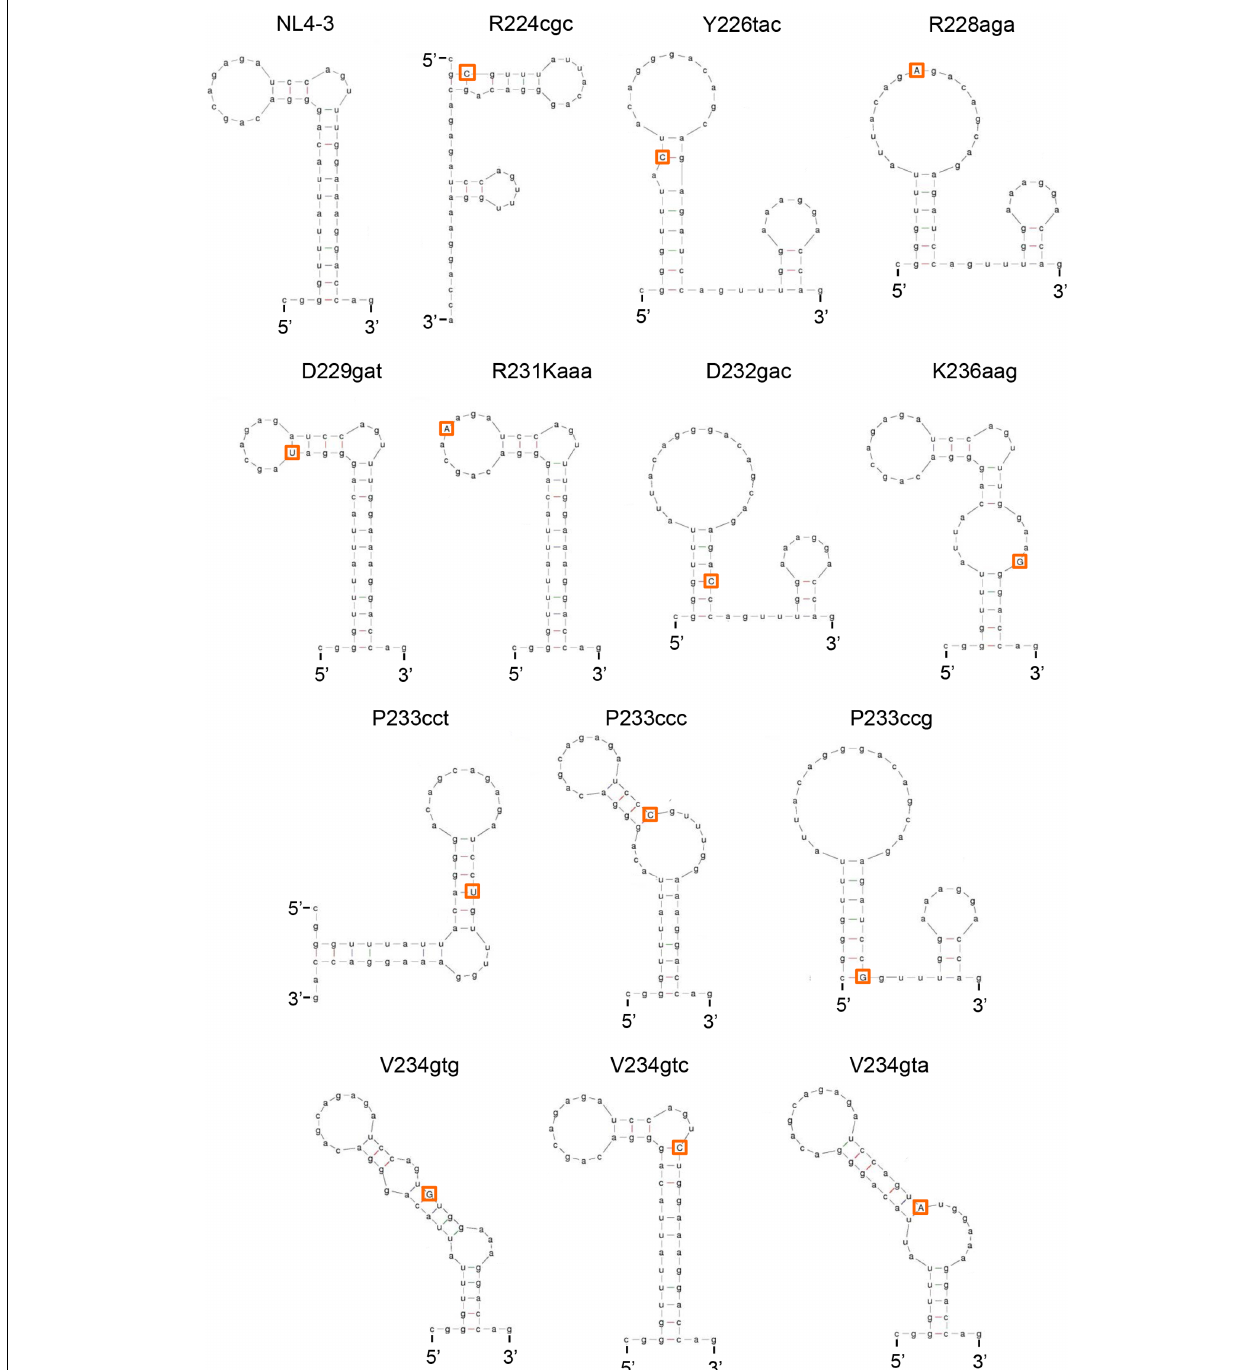
FIGURE 6 | Changes in SLSA1 RNA secondary structure by nSNVs within SLSA1. Various nSNVs analyzed are indicated by orange-boxed capital letters. Secondary RNA structure for the SLSA1 sequence carrying an nSNV was predicted by mfold program (Zuker, 2003).